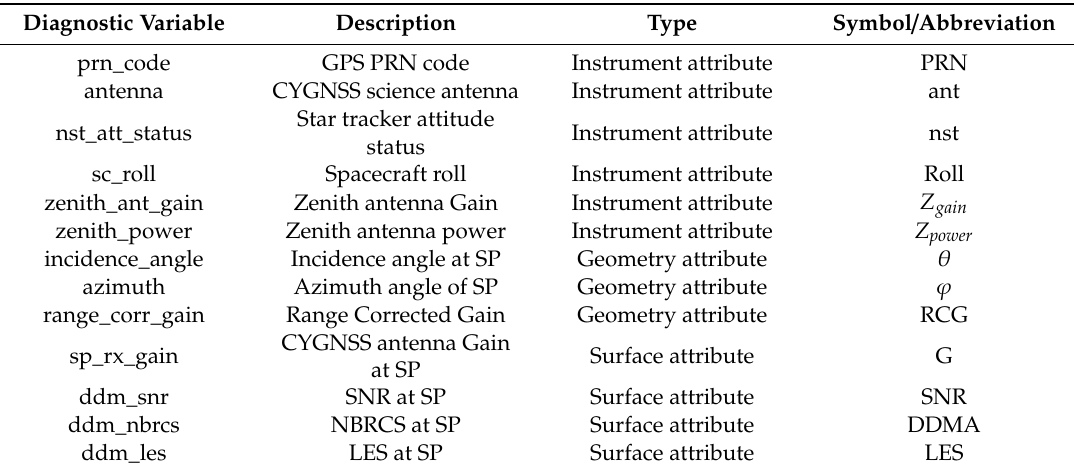
Table 1. List of diagnostic variables